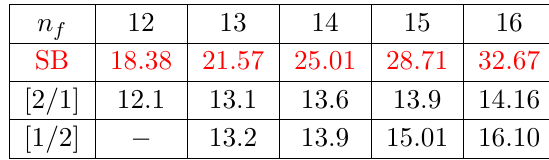
Table 1 . Comparison between the 3 d values of e F in the broken phase e F SB (red) with those obtained from Padé-approximants [2/1] and [1/2] of e F